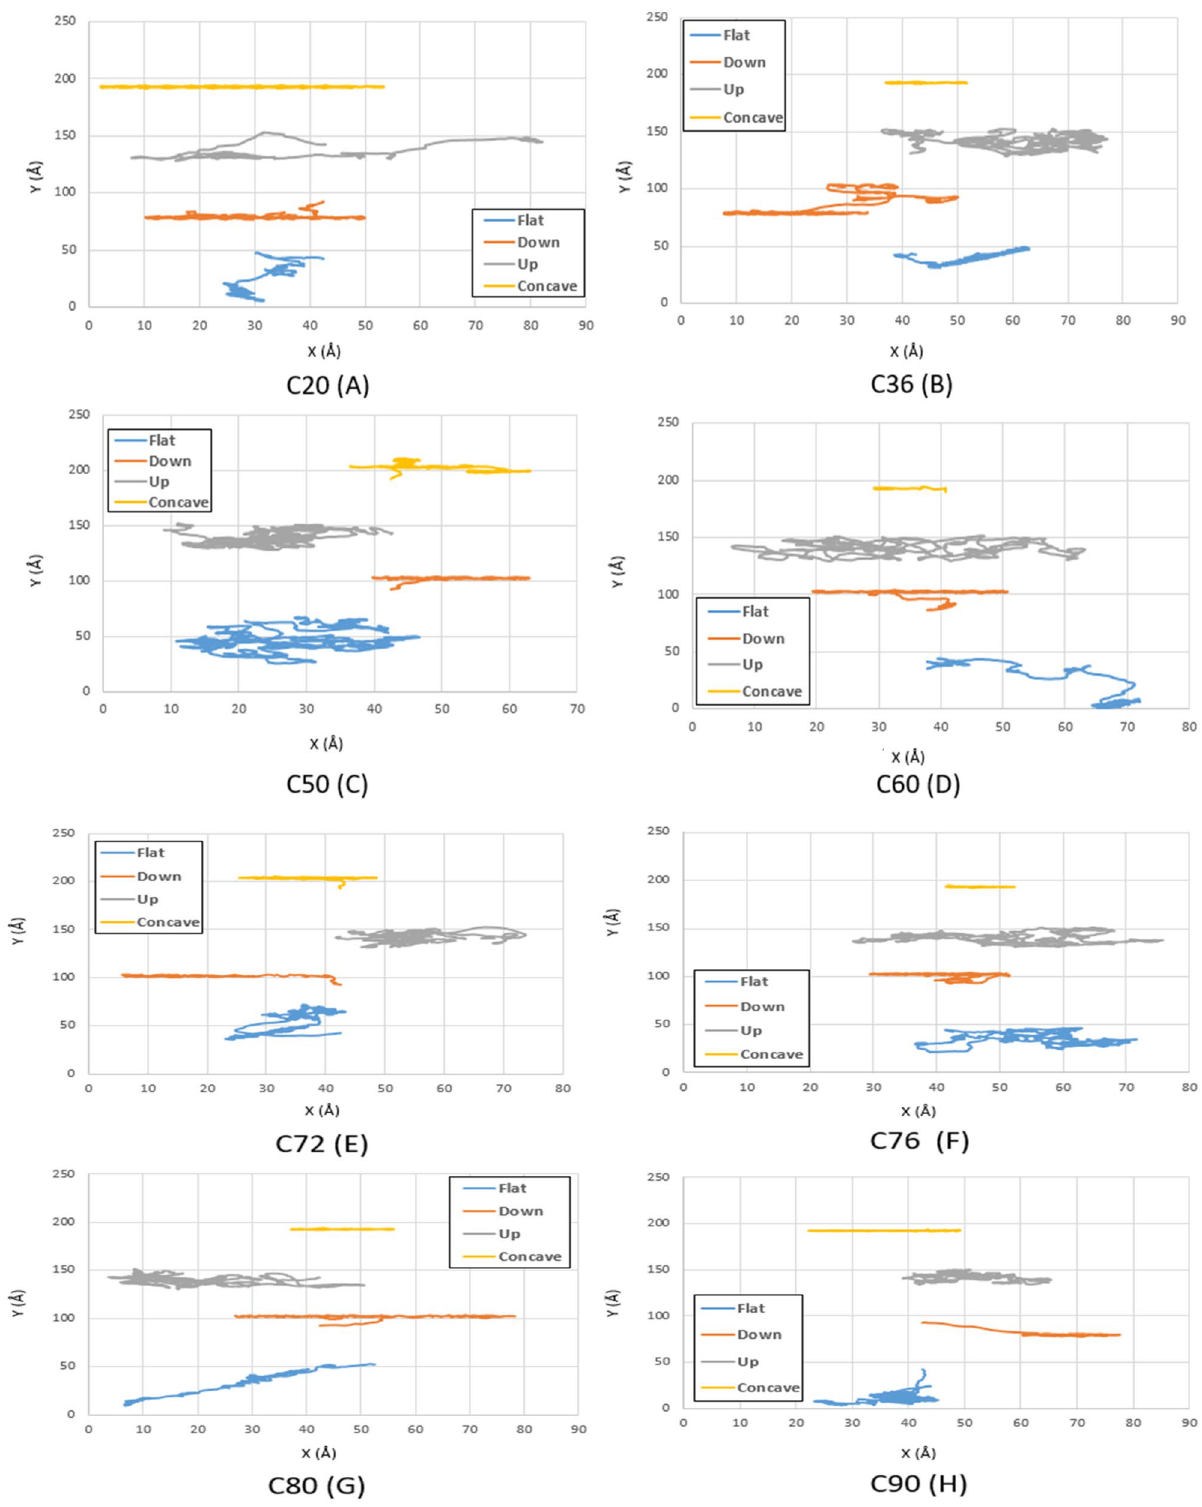
Figure 5. Trajectories of different fullerenes on a gold substrate at 300K for C 20 ( A ), C 36 ( B ), C 50 ( C ), C 60 ( D ), C 72 ( E ), C 76 ( F ), C 80 ( G ), and C 90 ( H ). The blue, red, black and yellow lines show the trajectories of the molecules on the flat, down side of the step, top side of the step, and concave substrates,